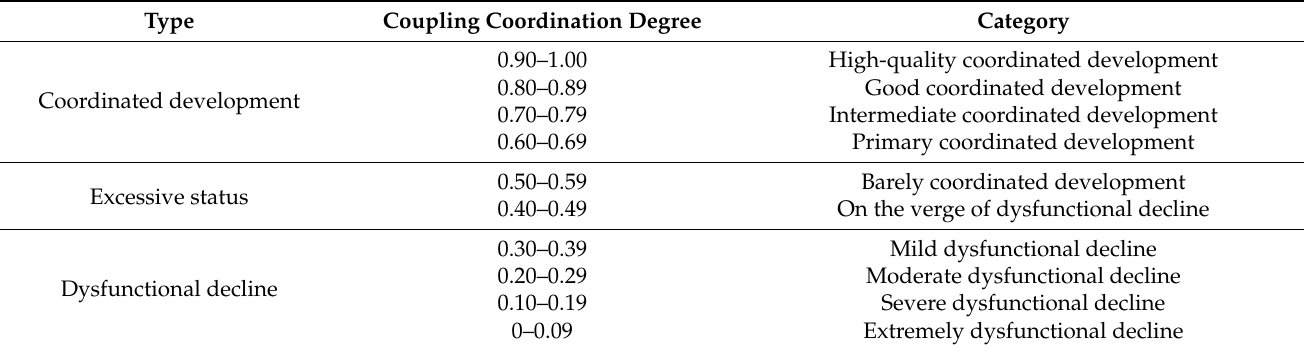
Table 2. Classification of coupling coordination